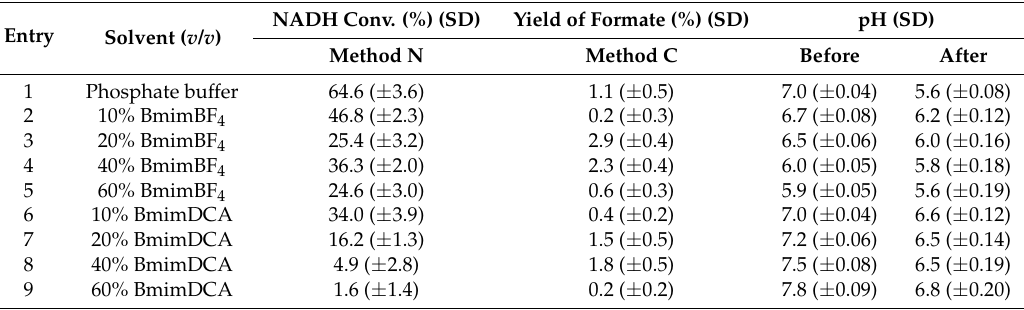
Table 3. Enzymatic Conversion of CO 2 to Formate a .